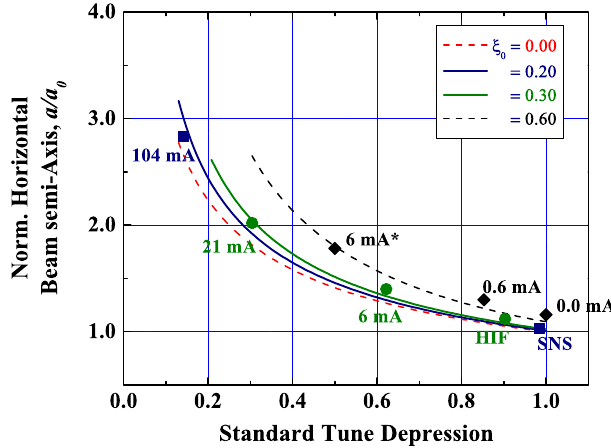
FIG. 1. Approximate normalized horizontal beam semiaxis as a function of standard tune depression [see Eq. (19)] for four values of the parameter (cid:2) 0 ¼ 2 D 0 (cid:1) =a 0 , with (cid:1) ¼ 0 : 0 for the first case (red dashed line) and (cid:1) ¼ 0 : 01 for the other three cases; all cases include full space charge. Five cases of beams in UMER are also indicated [exact calculations from Eqs. (14a)–(14c)] by their currents; the operating point in UMER is (cid:10) 0 ¼ 6 : 37 , and the edge emittances are given in Table I. Also shown are points for the proton ring at SNS andahypothetical ring forheavy-ion fusion (HIF).